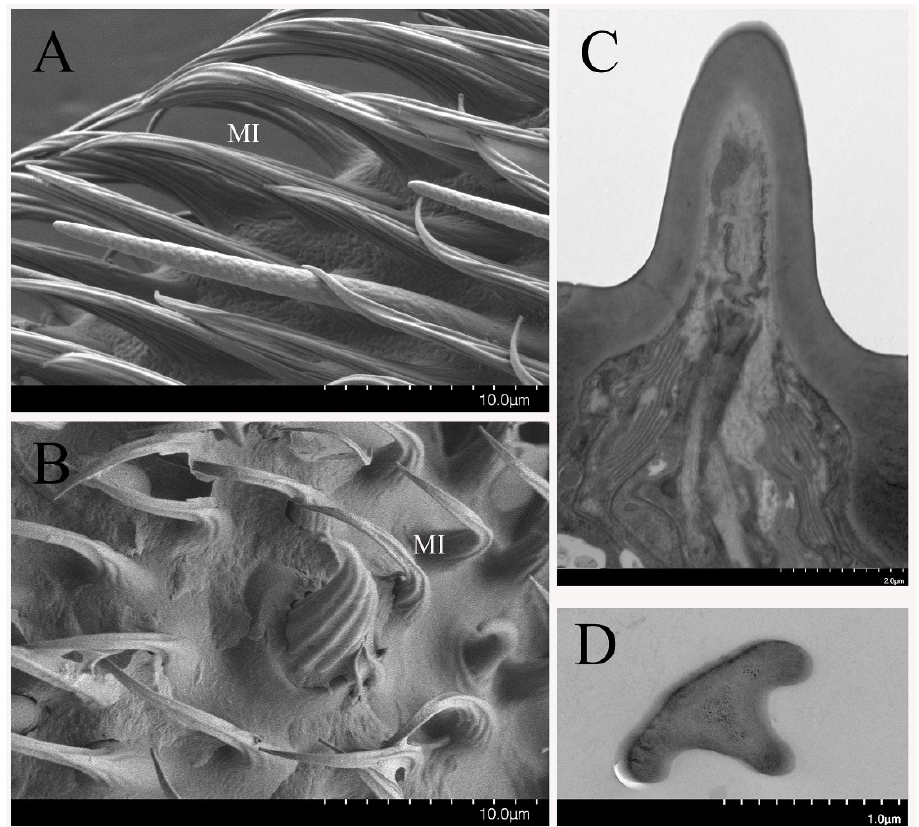
Figure 7. Microtrichia (MI) on B. dorsalis antennae ( A , C , D ) and maxillary palps ( B ). ( A , B ) Overview image shows the sharp tips and longitudinal grooves on the MI surface. ( C ) Longitudinal section of MI without cuticular pores and dendrites. ( D ) Cross-sections from the distal of this kind of sensillum.